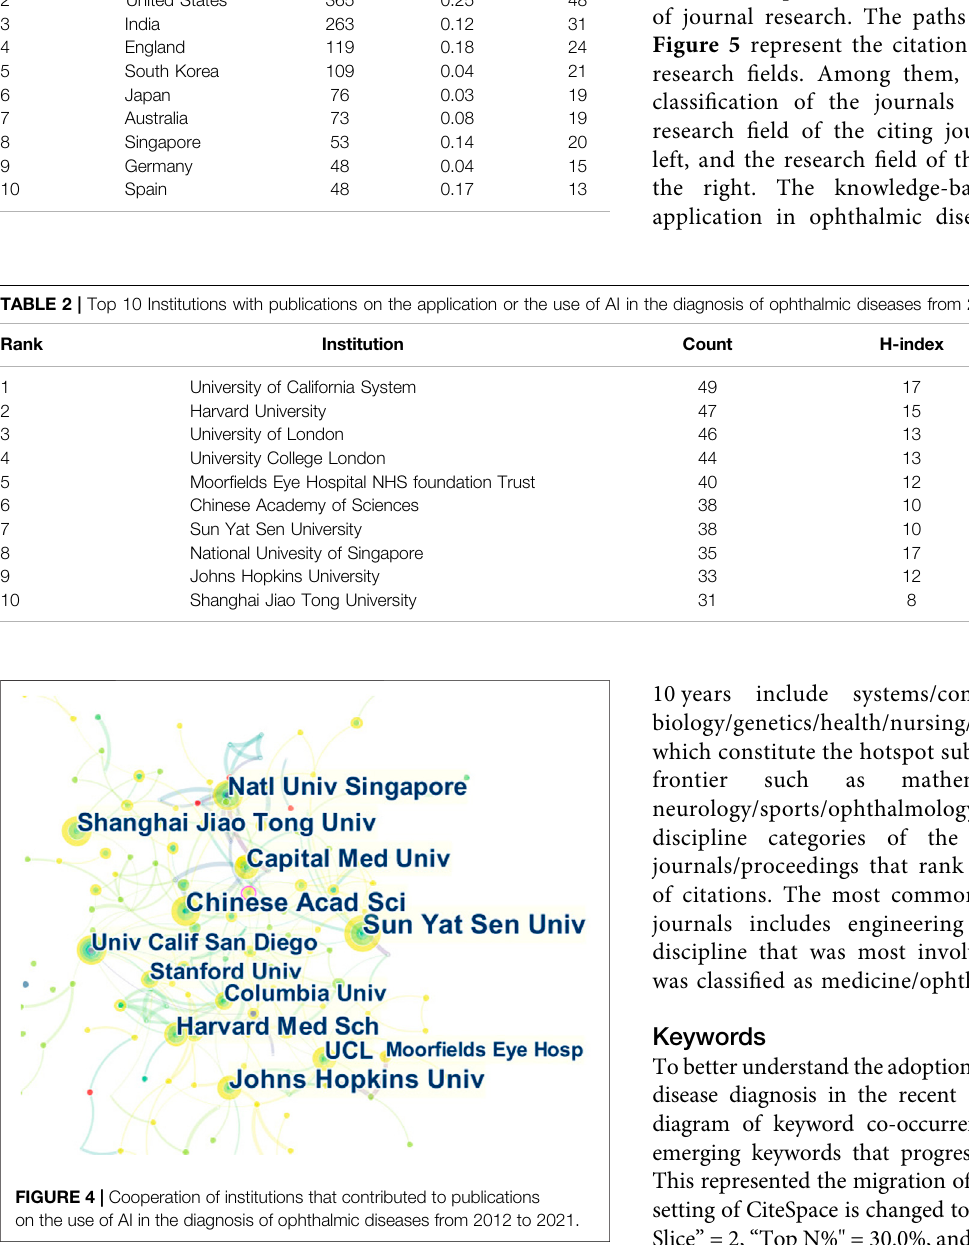
Frontiers in Pharmacology |